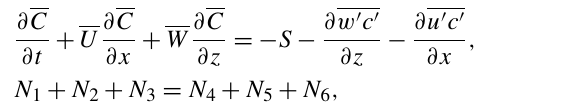
where t is time, x and z are the longitudinal and vertical di- rections, respectively, C is the scalar concentration, U and W are the longitudinal and vertical velocity components, w (cid:48) c (cid:48) and u (cid:48) c (cid:48) are the turbulent scalar fluxes in the vertical and horizontal, respectively, S represents the net sources or sinks (physical, chemical, and biological) of C , and the overline represents time averaging over turbulent scales. The six terms in this equation represent the following (left to right): local rate of change ( N 1 ), horizontal advection by the mean ve- locity ( N 2 ), vertical advection by the mean velocity ( N 3 ), net sources or sinks ( N 4 ), net vertical transport by the ver- tical turbulent flux gradient ( N 5 ), and net horizontal trans- port by the horizontal turbulent flux gradient ( N 6 ). Generally, | (cid:28) | N | and is hereafter ignored in the discussion. | N 6 5 During the non-inversion night, the ground O 3 could be re- plenished by vertical turbulent transport ( N 5 ), mean vertical advection from the upper boundary layer ( N 3 ), or horizon- tal advection below the canopy ( N 2 ) (as shown in Fig.